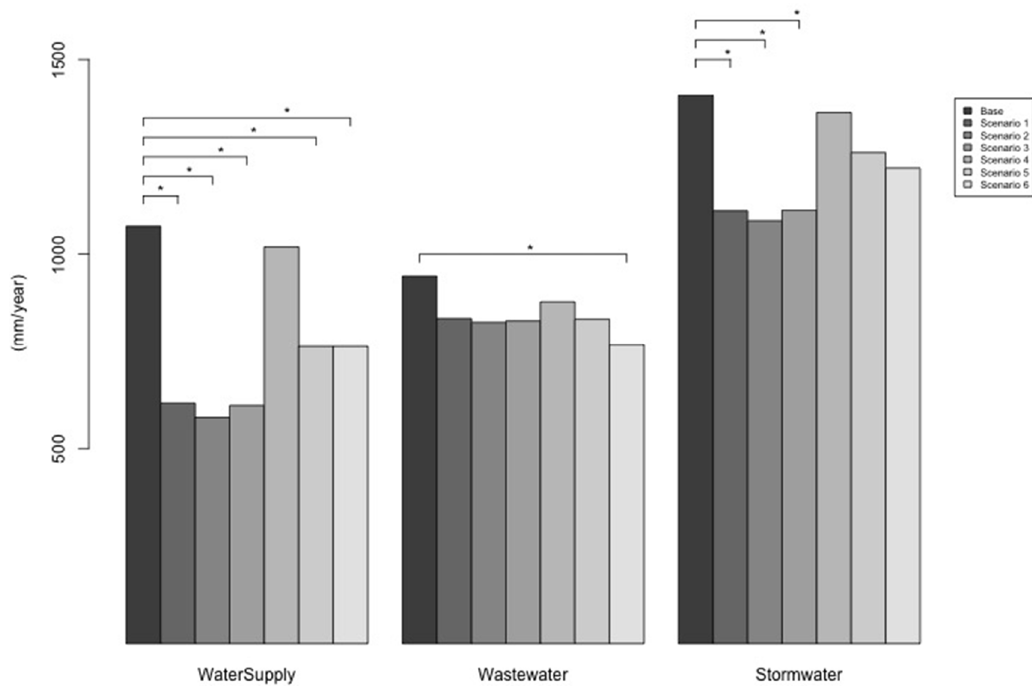
Figure 2. Flow of Drinking Water, Wastewater, and Stormwater in the Fucha Catchment.